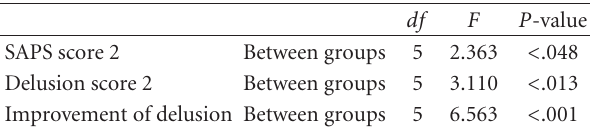
Table 2: ANOVA for change of opinion from 1st to 2nd